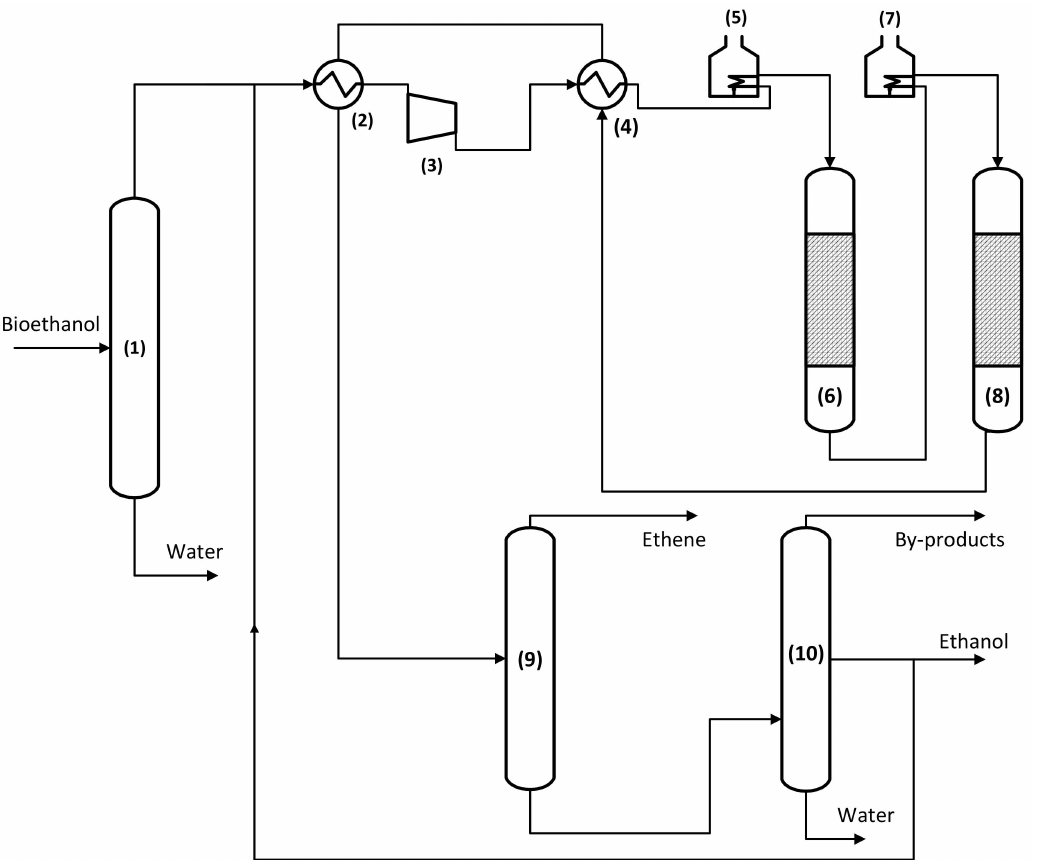
Figure 1. Flow sheet of an ethanol dehydration plant [6] consisting of (1) a pretreatment distillation column, (2) and (4) heat exchangers, (3) a compressor, (5) and (7) heating furnaces, (6) and (8) ethanol dehydration reactors, and (9) and (10) gas / liquid separation